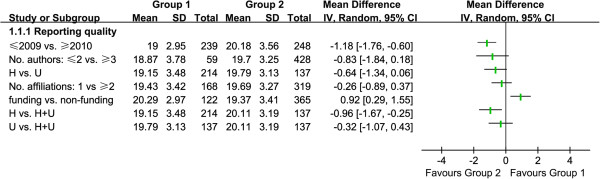
Stratified analysis of included SRs/MAs.